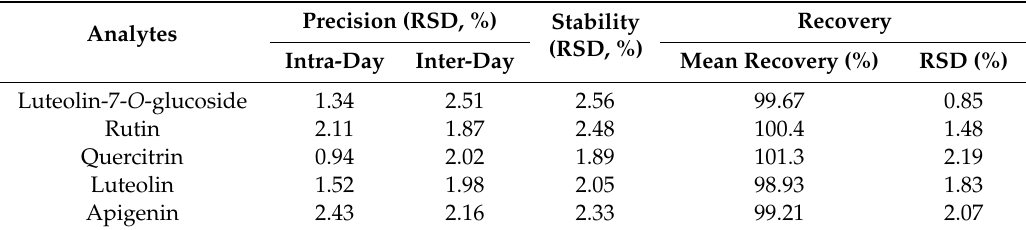
Table 4. Precision, stability, and recovery of the five tested